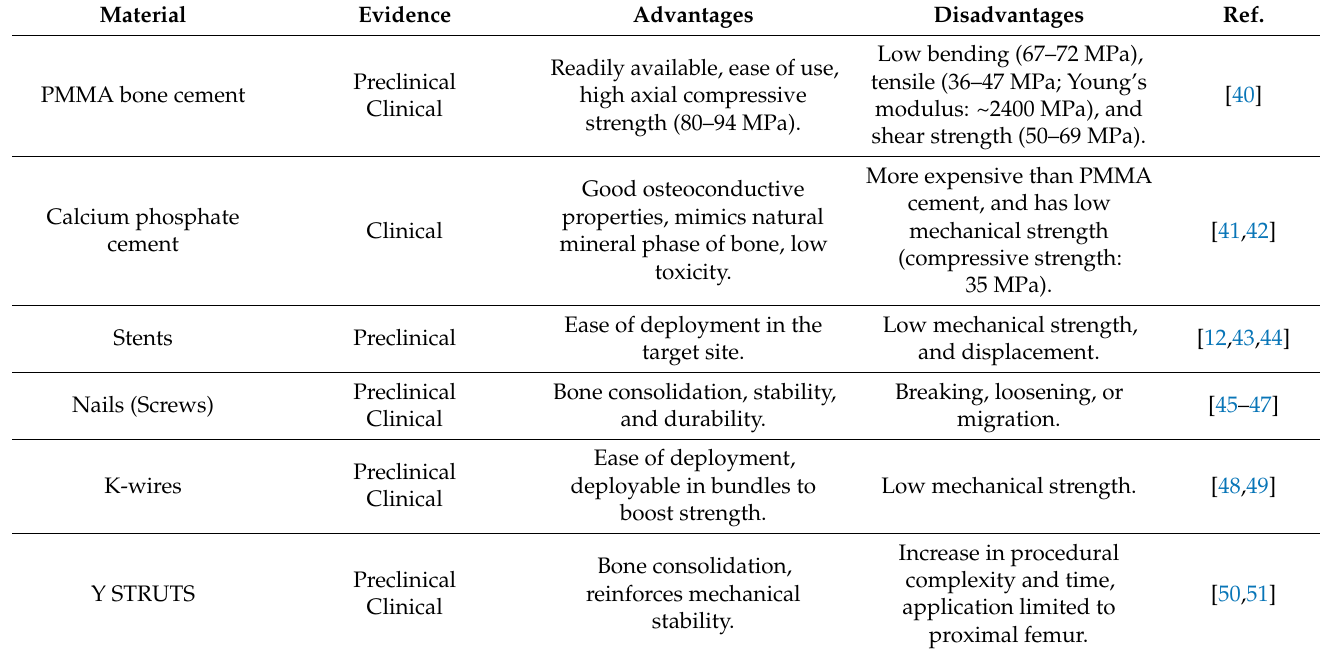
Table 2. Materials commonly used for reinforcements in percutaneous